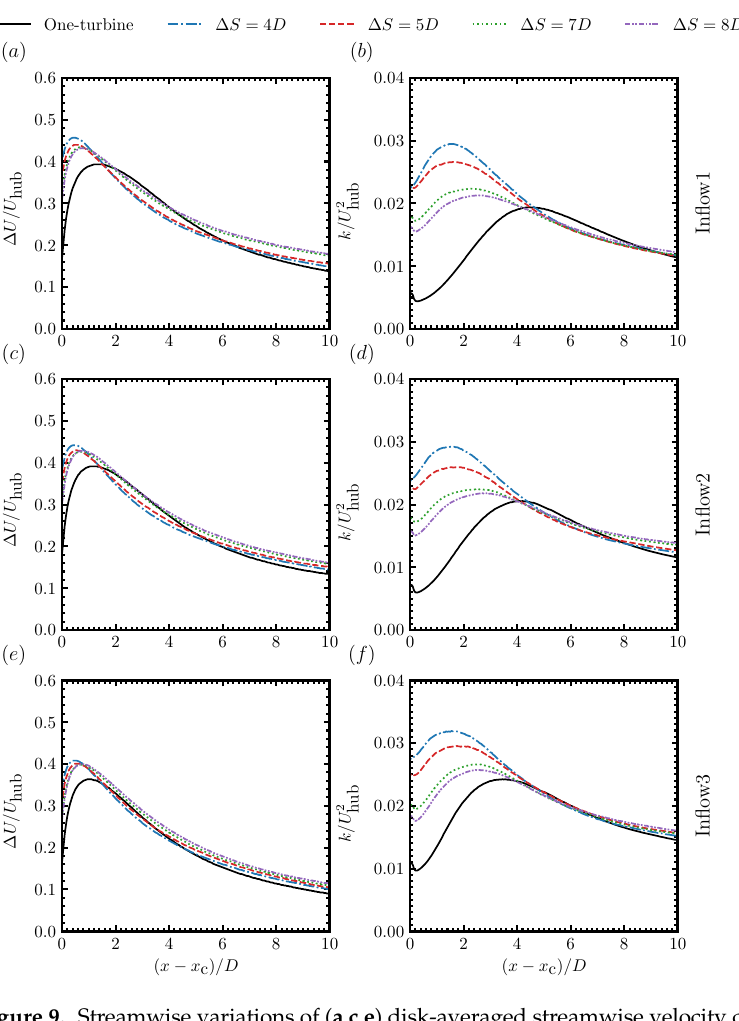
Figure 9. Streamwise variations of ( a , c , e ) disk-averaged streamwise velocity deficit, and ( b , d , f ) disk- averaged turbulence kinetic energy at different streamwise positions under different inflows.